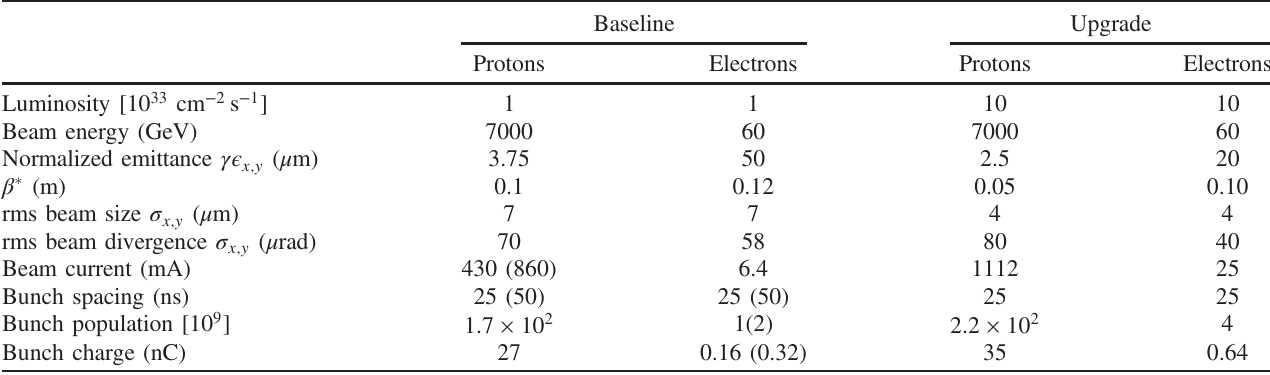
TABLE I. L-R LHeC baseline and possible upgrade parameters.